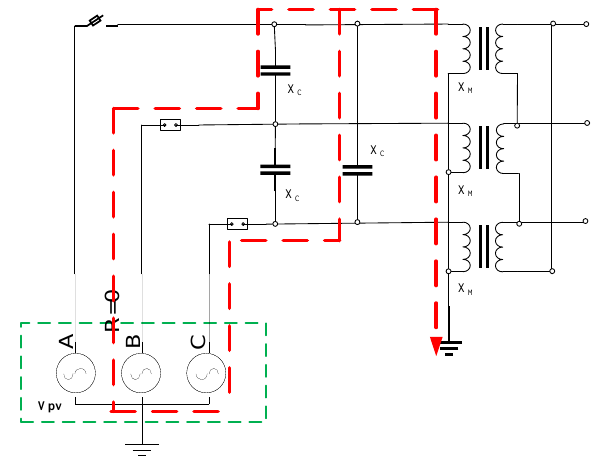
Figure 11. The single line diagram of a PV rooftop system with a 500 kVA transformer and a light load connected.